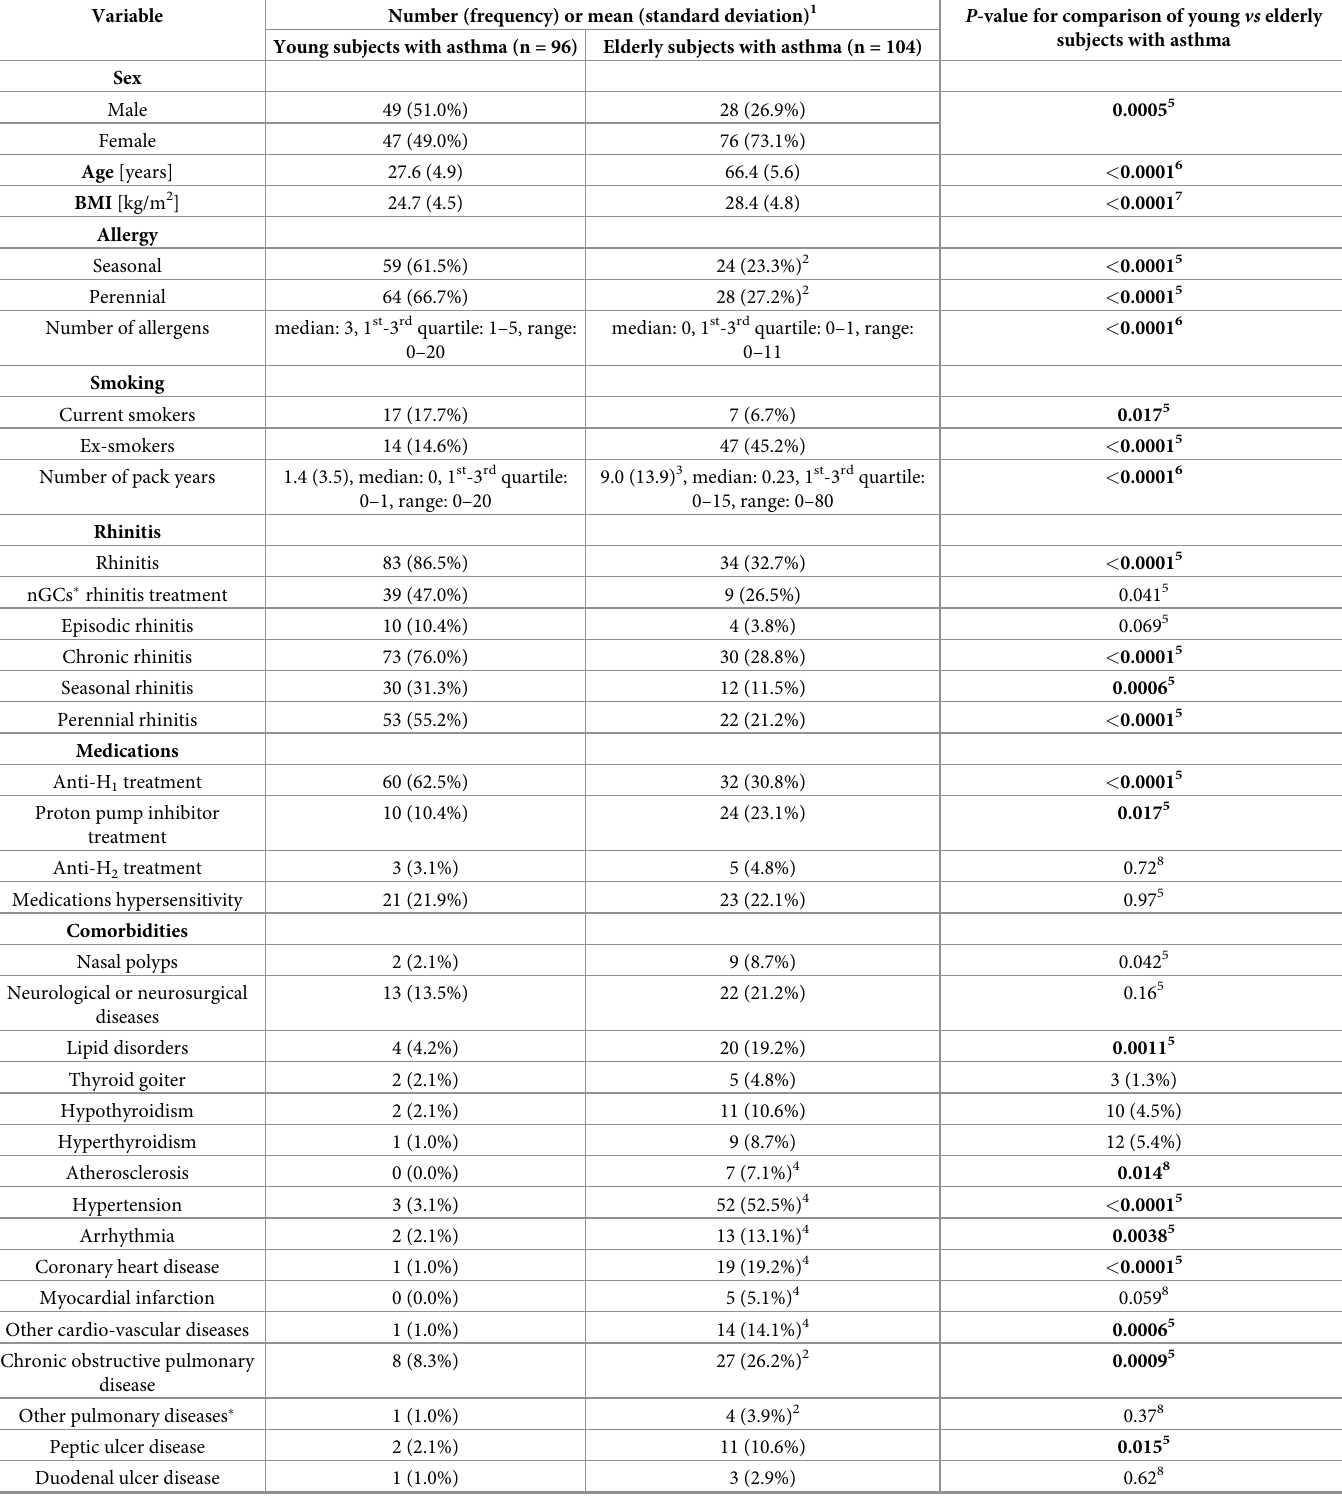
Table 1. Detailed characteristics and description of young (18–35 years old) and elderly asthmatic patients (aged � 60 years).